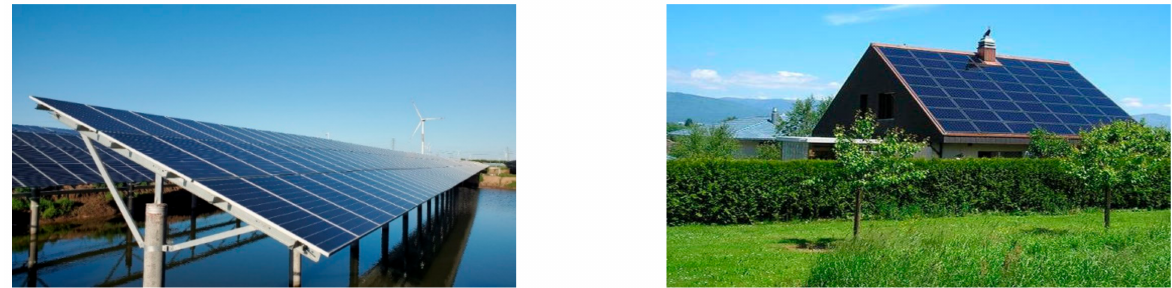
Figure 1. Fixed support PV structure